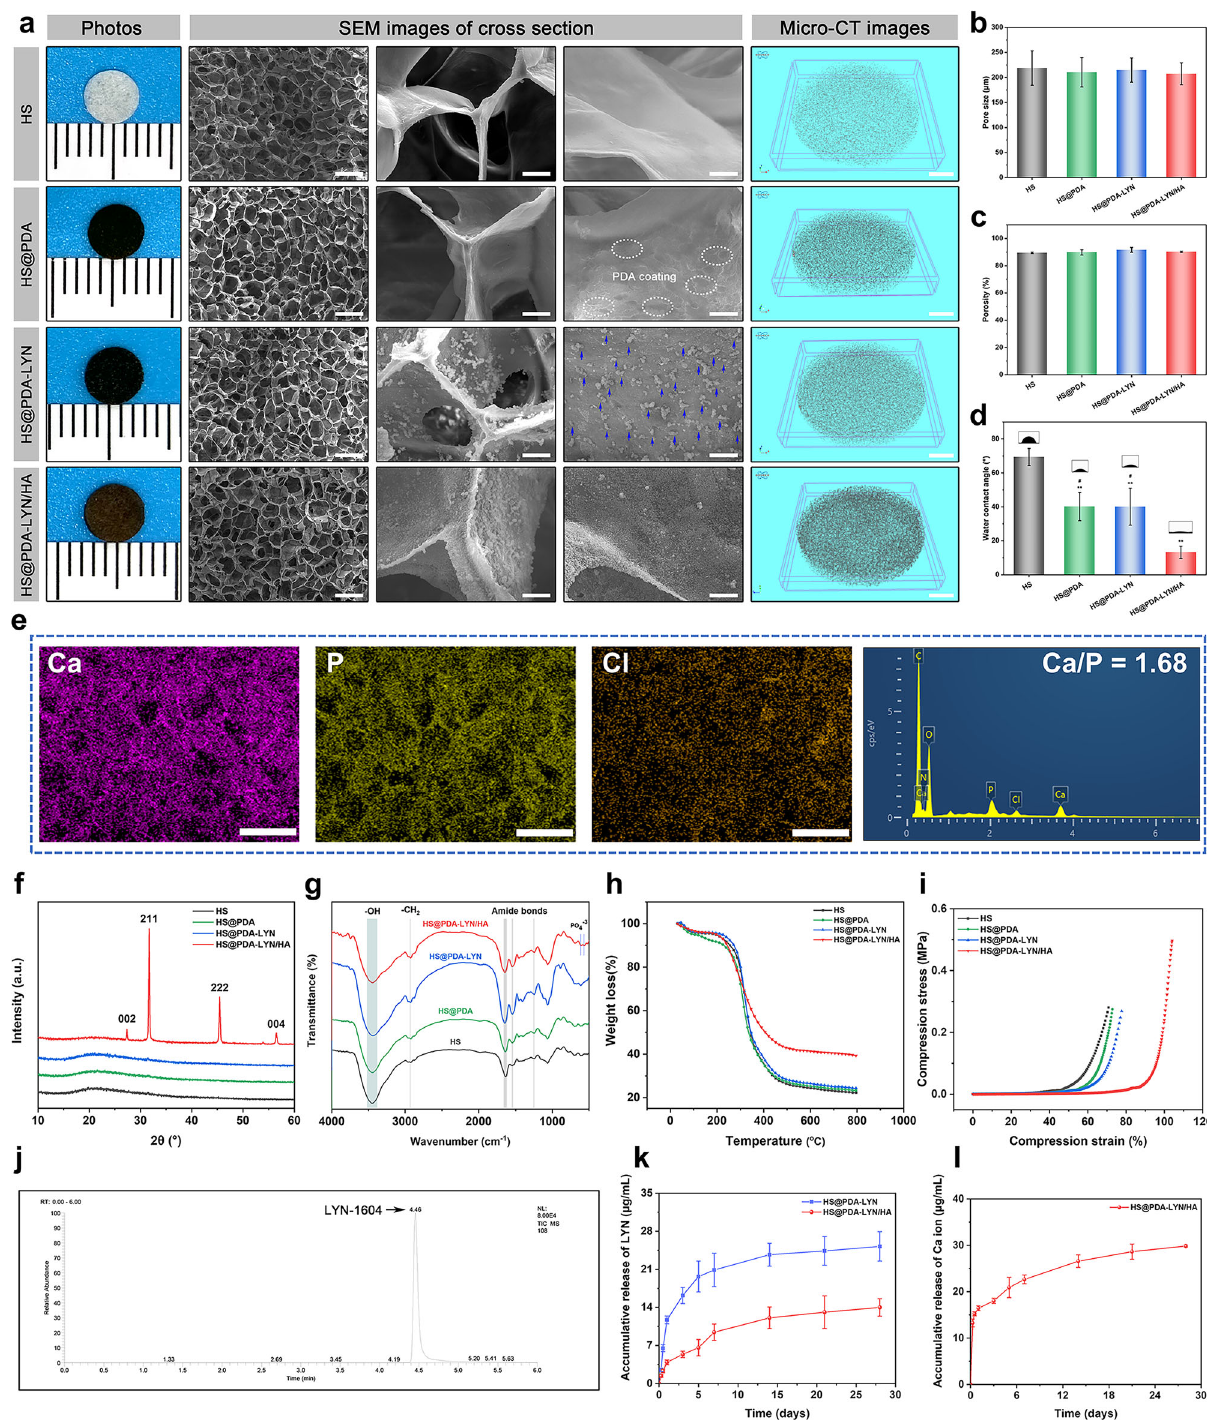
Fig. 2 Morphology and characterization of surface-modi fi ed HS 3D scaffolds with LYN and HA via bioinspired dopamine chemistry. a Representative optical appearance and microstructure of different scaffolds after freeze-drying as observed by SEM and micro-CT. The blue arrows indicate the immobilization of LYN on the scaffold surface. b Average pore size, c porosity, and d WCA of the four kinds of scaffolds. e EDS mapping images and spectrum of HS@PDA-LYN/HA. f XRD spectra. g FTIR spectra. h TGA analysis of different scaffolds under a N2 atmosphere. i Representative stress – strain curve of scaffolds under compression. j Representative HPLC – MS/MS image of the HS@PDA-LYN/ HA scaffold. k Accumulative LYN concentration released from HS@PDA-LYN/HA and HS@PDA-LYN/HA samples in Tris-HCl buffer solution. l Accumulative Ca ion concentration released from HS@PDA-LYN/HA samples in Tris-HCl buffer solution. Scale bar in a : from left to right 300, 20, 10 μ m, 1 mm, in e : 250 μ m. Data are expressed as the mean ± SD ( n = 3). * P < 0.05 and ** P < 0.01 indicate signi fi cant differences compared with the HS group. # P < 0.05 and # # P < 0.01 indicate signi fi cant differences compared with the HS@PDA-LYN/HA